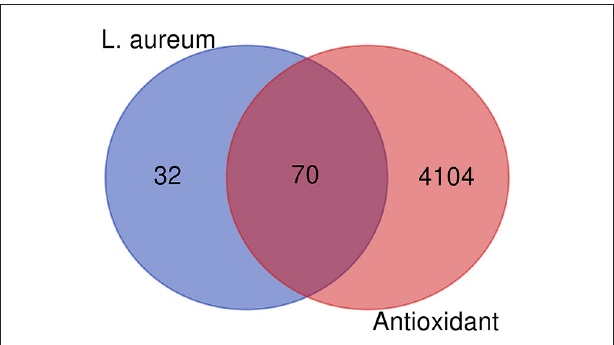
FIGURE 5 | Venn diagram showing all candidates, interaction targets of L. aureum , and antioxidant.